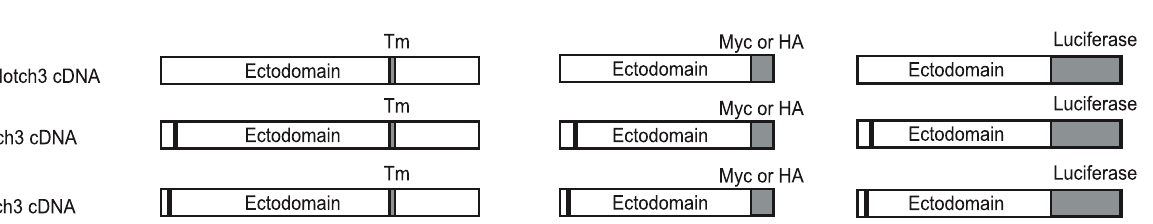
Figure 1. Constructs used in this study. Schematic representation of constructs used in this study, as described in the methods. The positions of the mutations examined in the present study are indicated by small dark rectangles. Wildtype and mutant constructs were all cloned into pCMV- Sport6 (Invitrogen). Tm = transmembrane domain of NOTCH3, which is deleted in tagged constructs. The constructs were prepared in pCMV-Sport6 (Invitrogen). Tagged NOTCH3 ectodomain constructs were prepared by replacing the C-terminal 3 kb of NOTCH3 with either an HA or myc tag or with the full coding sequence of firefly luciferase. The HA and myc tagged proteins run on SDS gels at an apparent molecular weight of 175 kDa.